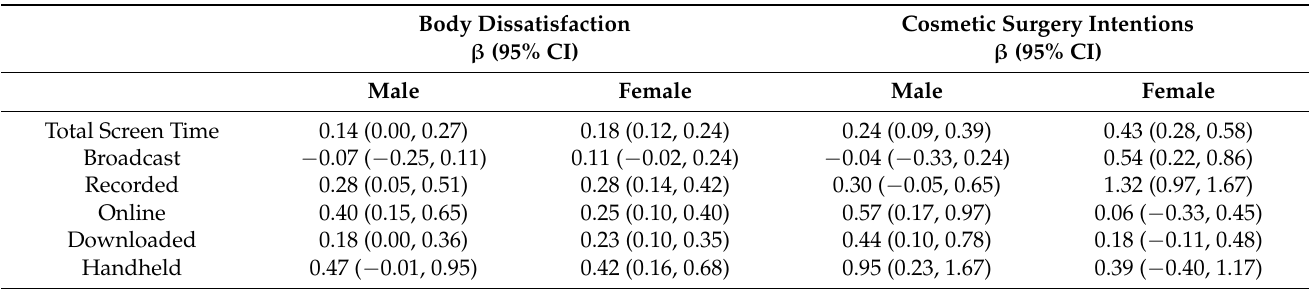
Table 2. Sex-stratified associations * of television viewing time and different screen viewing modes with body. Dissatisfaction and cosmetic surgery intention among GUTS